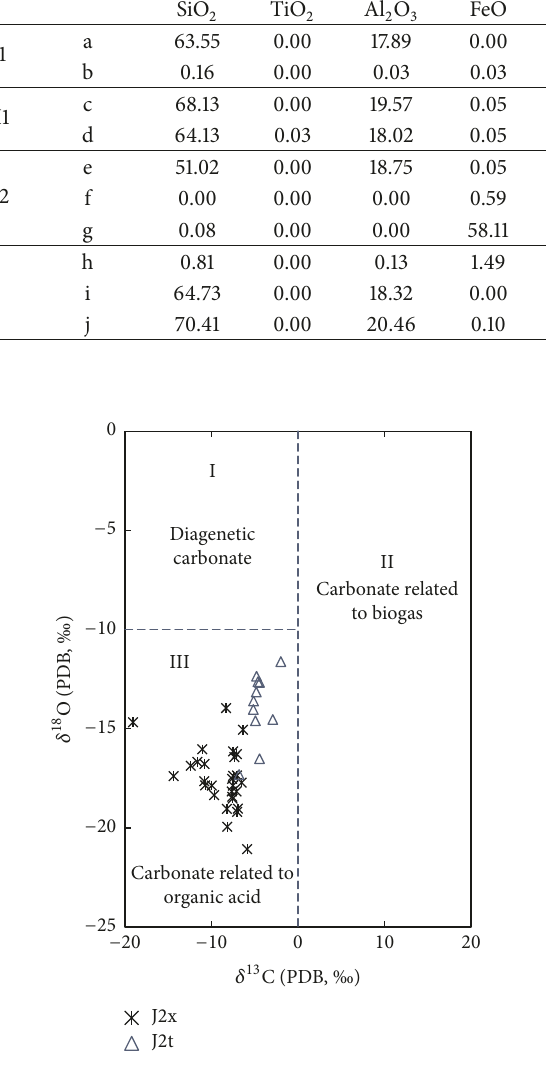
Figure 7: Stable isotopic data of carbon and oxygen for carbonate cements of Block 3.